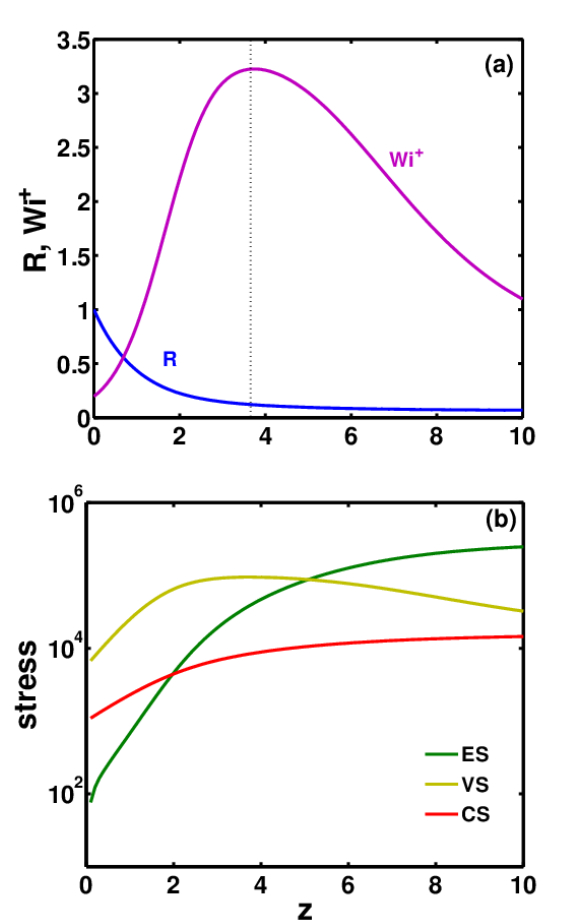
Figure 3. Typical profile of ( a ) jet radius R (blue curve) and local Weissenberg number Wi + (pink curve) and ( b ) elastic (green curve), viscous (yellow curve) and capillary stresses (red curve) as function of z starting from nozzle tip to the end of steady jet